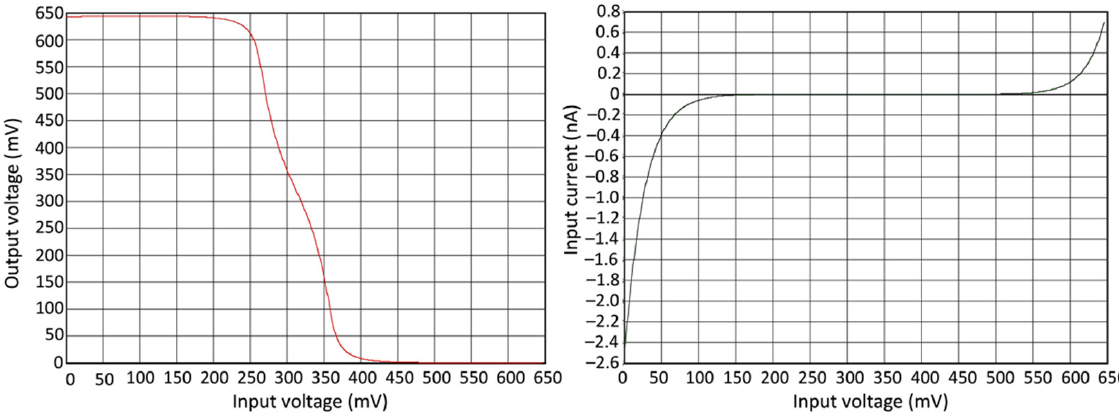
Figure 9. Transfer characteristic and input current of a thermally stabilized CBip inverter (Figures 7 and 8). V CC = 1 V, R=10 M Ω , temperature 300 K.